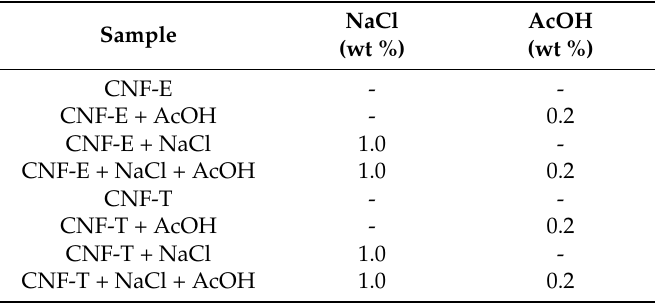
Table 1. Added amount of acetic acid (AcOH) and NaCl to a series of 0.5 wt % CNFs and 40 wt % rapeseed oil